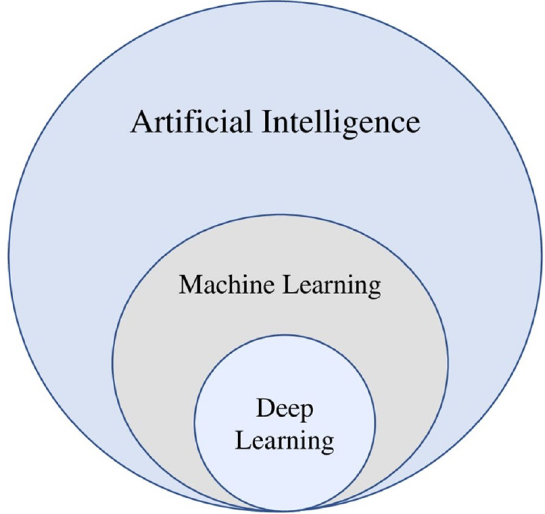
Fig. 1 Deep learning, machine learning, and artificial